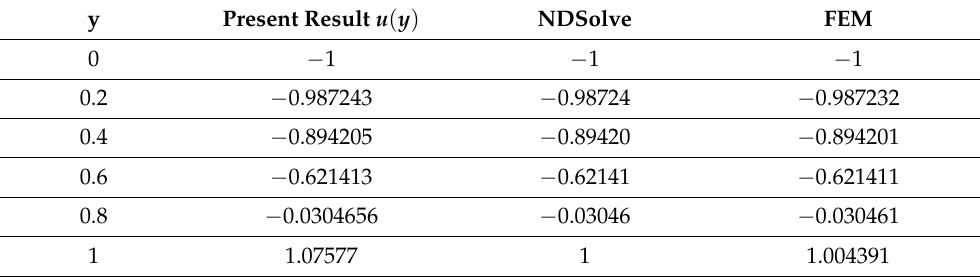
Table 1. Comparison of the velocity distribution u ( y ) obtained by MS-DTM with NDSolve and FEM solution for G rT = 0.5, G rC = 0.5, G rF = 0.5, N CT = 0.7, N TC = 0.7, N b = 0.5, N t = 0.5, D a = 10, P r = 7, λ 1 = 0.6, M = 0.2.